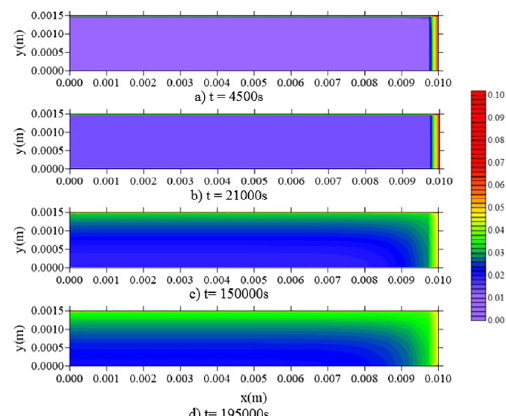
Figure 10. Distribution of the entrapped solute concentration (S) in x = R /2 plane for different water absorption times x